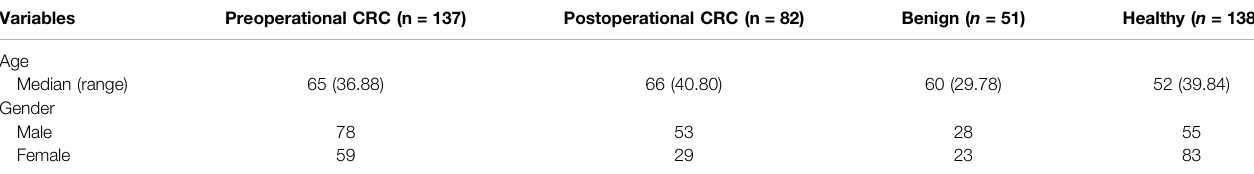
TABLE 1 | Demographic and clinical characterization of the study population.